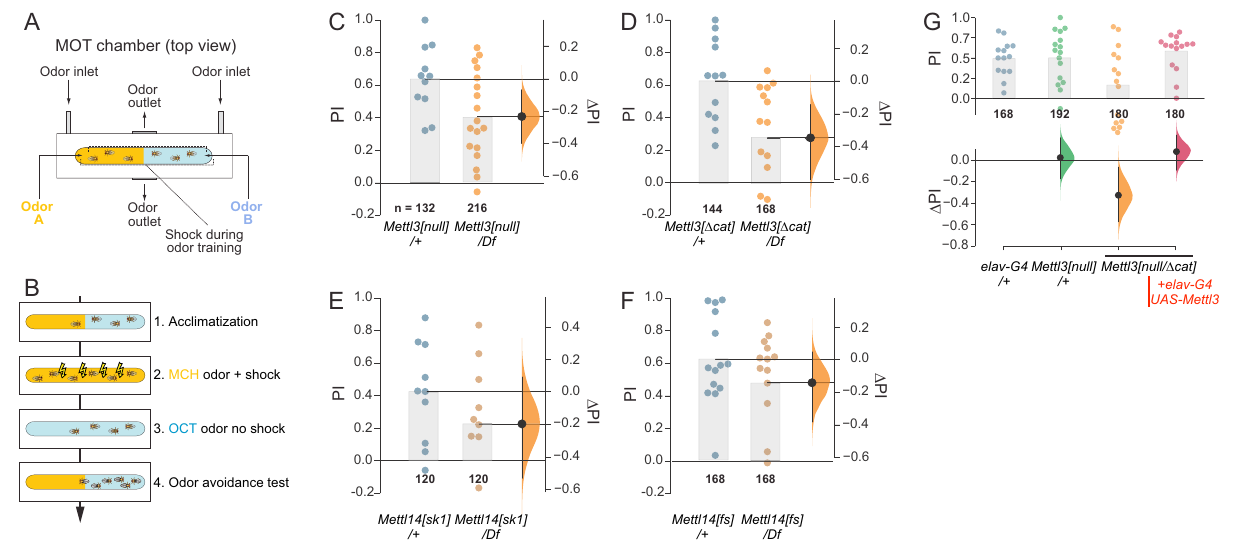
Fig. 2 m 6 A pathway is required for short-term learning and memory (STM) in Drosophila . A Schematic of the multi fl y olfactory training (MOT) chamber apparatus used for behavioral measurements. B Paradigm for shock-associated odor avoidance assay for STM acquisition. C and D Hemizygote null conditions for Mettl3[null] and Mettl3[ Δ cat] both led to STM impairment. Mettl3[null] / Df ( n = 216) vs. Mettl3[null] / + ( n = 132) = − 0.23[95CI − 0.4, − 0.06] p = 0.033. Mettl3[ Δ cat ]/ Df ( n = 168) vs. Mettl3[ Δ cat ]/ + ( n = 144) = − 0.35[95CI − 0.6, − 0.14] p = 0.017. E and F Hemizygote null conditions for Mettl14[fs] and Mettl14[sk1] led to a mild STM impairment. Mettl14[sk1 ]/ Df ( n = 120) vs. Mettl14[sk1 ]/ + ( n = 120) = − 0.19[95CI − 0.52, + 0.14] p = 0.345. Mettl14[fs ]/ Df ( n = 168) vs. Mettl14[fs ]/ + ( n = 168) = − 0.15[95CI − 0.37, + 0.06] p = 0.505. G Pan-neuronal expression of UAS-Mettl3 using elav-Gal4 ( elav-G4 ) in Mettl3[null] hemizygotes rescued their STM phenotype . Mettl3[null]/ + ( n = 192) vs. elav-G4/w 1118 ( n = 168) = + 0.02[95CI − 0.17, + 0.21] p = 0.647. Mettl3[null] / Mettl3[ Δ cat] ( n = 180) vs. elav-G4/w[1118] ( n = 168) = − 0.33[95CI − 0.57, − 0.07] p = 0.085. Mettl3[null]/Mettl3[ Δ cat] + elav- G4 UAS-Mettl3 ( n = 180) vs. elav-G4/w[1118] ( n = 168) = + 0.08[95CI − 0.1, + 0.22] p = 0.132. All assays in C – F were conducted in 20-day-old fl ies. Bars present mean values. Each dot in the scatter plots represents a PI average of 12 fl ies. All control – test differences are displayed as effect sizes with error curves and 95% con fi dence intervals. No null-hypothesis signi fi cance testing was performed; two-tailed Mann – Whitney P values are shown for legacy purposes only. For multiple comparisons, several test groups were compared against a common control group. PI = performance index. Source data are provided as a Source Data fi